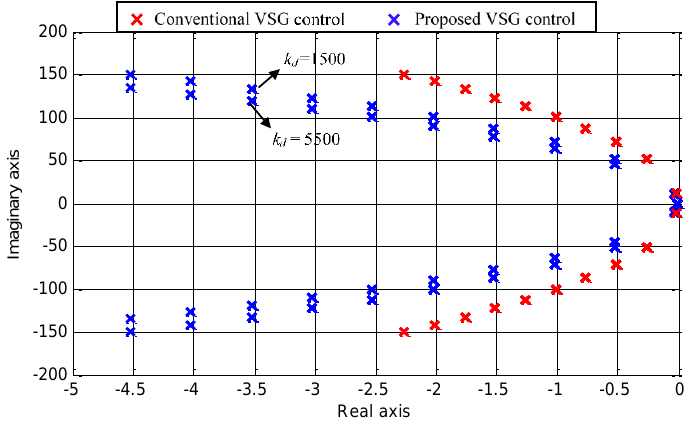
Figure 10. Root locus plot of the converters when increasing the derivative coefficient.